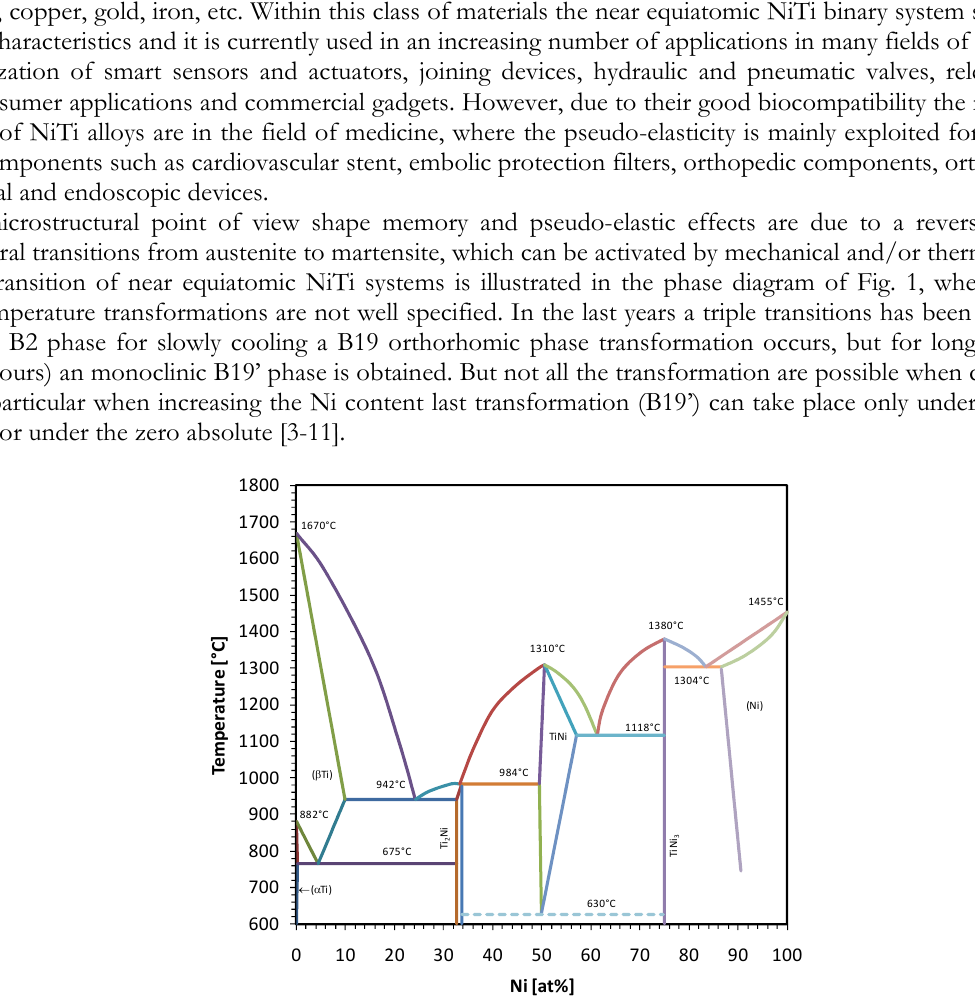
Figure 1: NiTi alloy phase